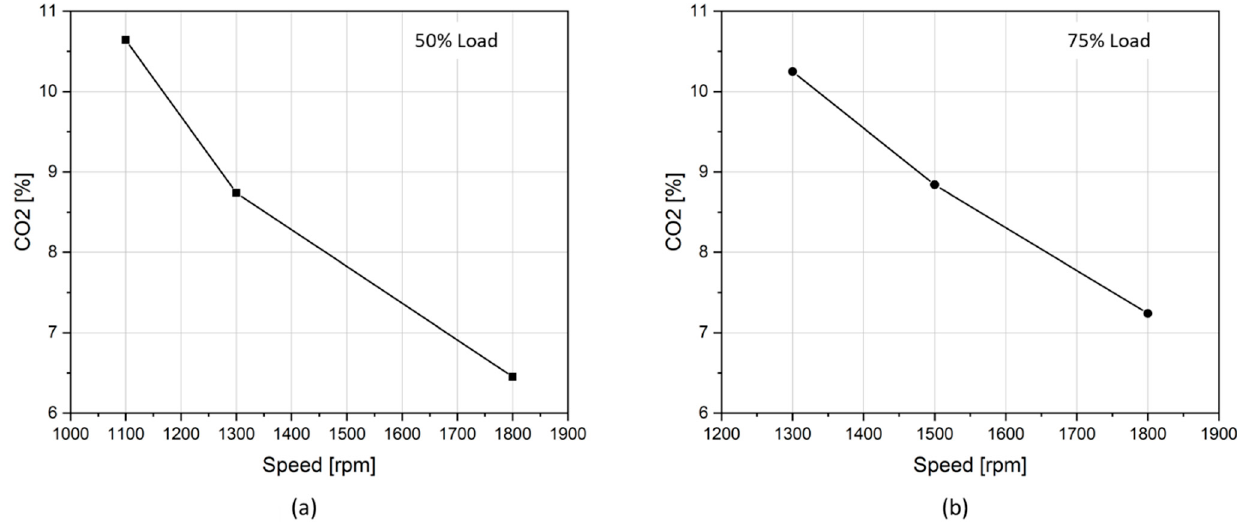
Figure 8. CO 2 emissions according to different engine speeds at ( a ) 50% and ( b ) 75% load.